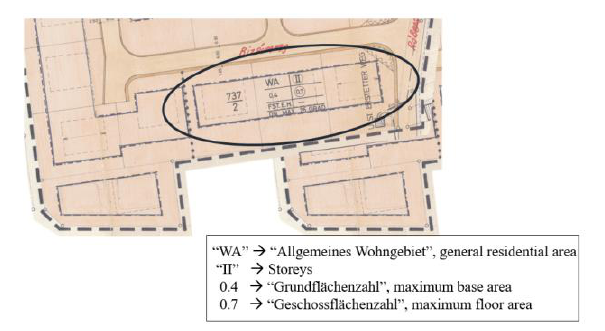
Figure 3 : Binding Plan of Eggingen District